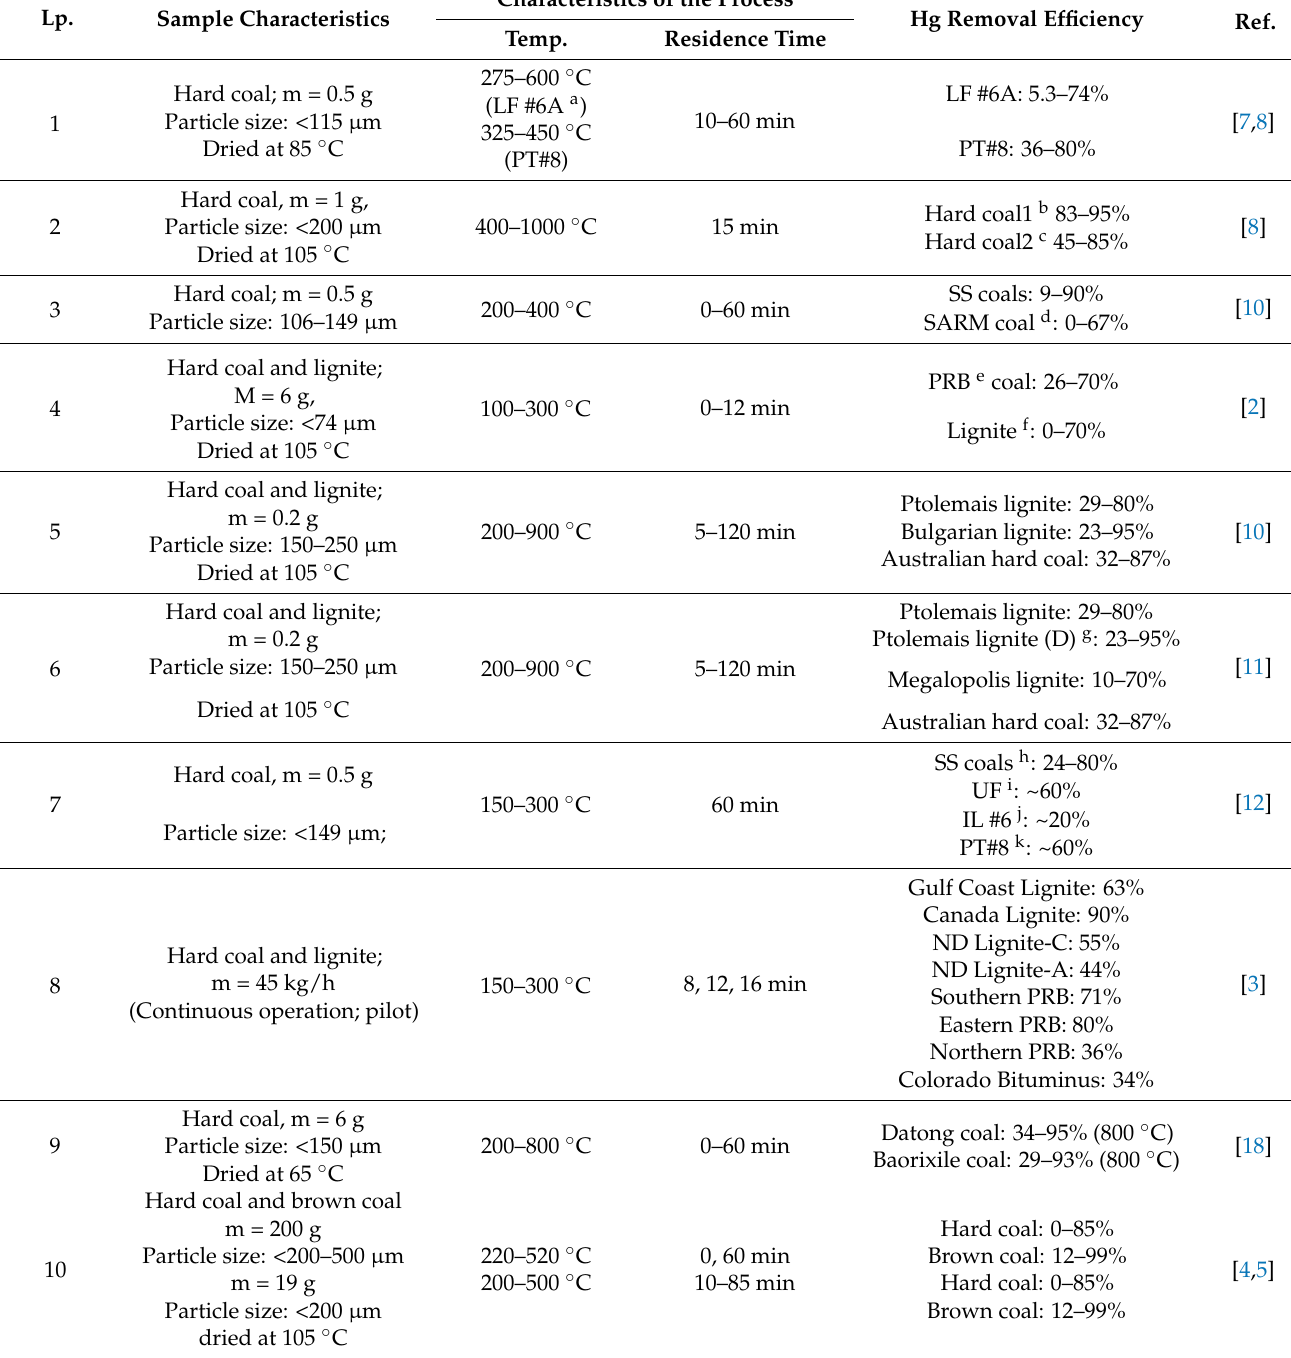
Table 1. Published data concerning Hg removal from coal by low-temperature pyrolysis